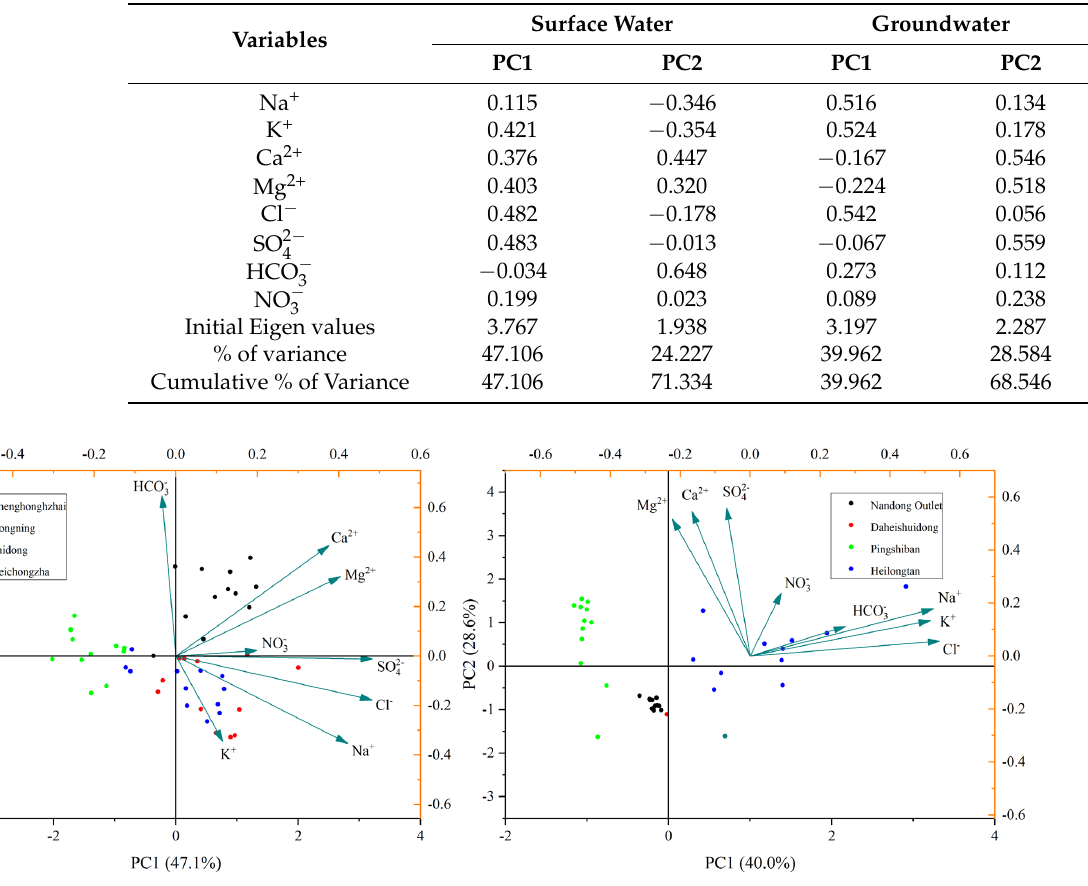
Figure 4. PCA representation for surface water samples and groundwater samples.